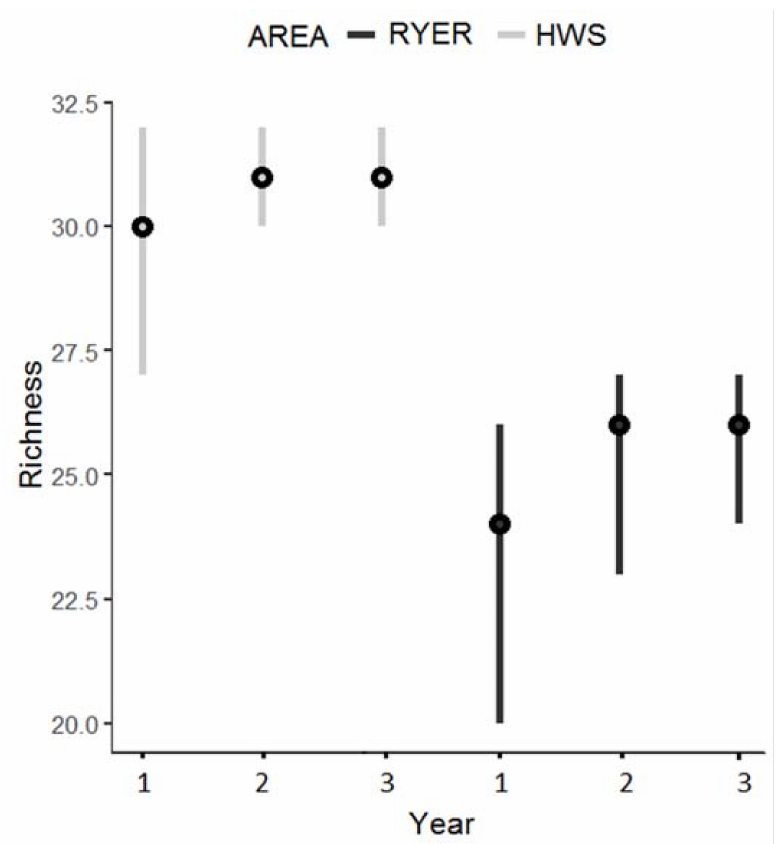
Figure 2. Estimated species richness during the 3 years of monitoring in both areas (Htamanthi Wildlife Sanctuary (HWS): light grey; Rakhine Yoma Elephant Range (RYER): black) with median (black dots) and 95% Bayesian credible intervals.